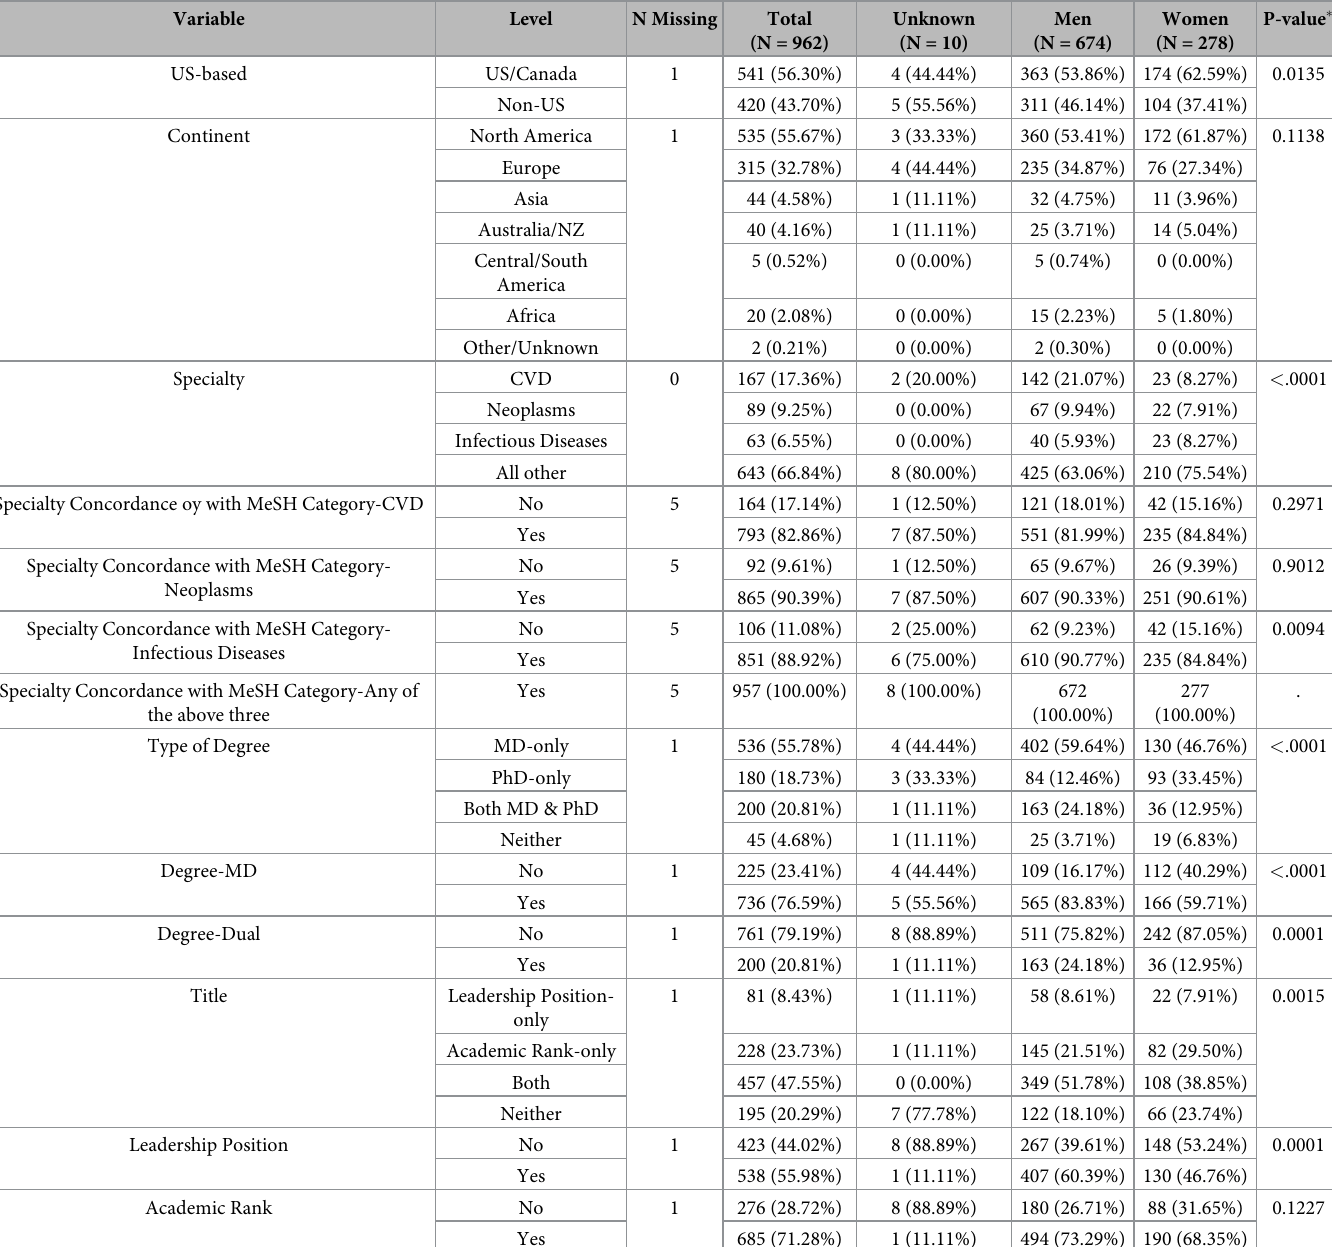
Table 4. Top medical research journals: First authors’ publication’s characteristics by gender (2002 to 2019).